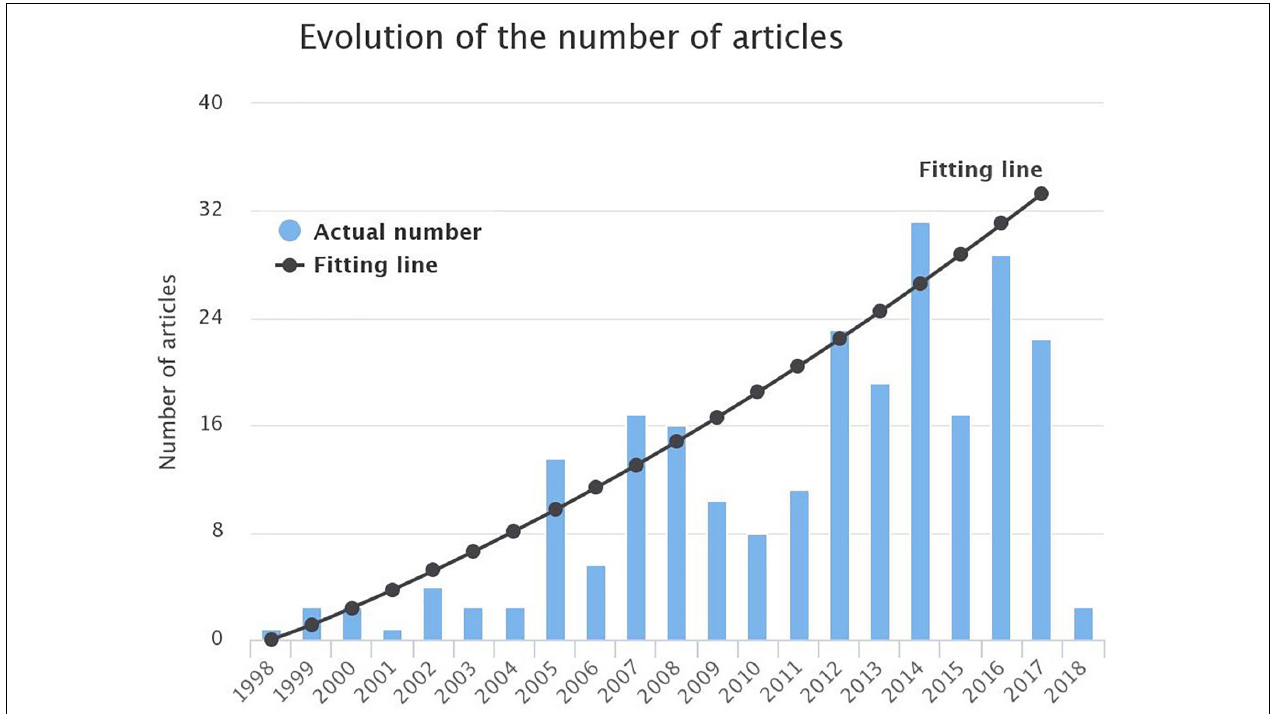
FIGURE 4 | Evolution of the number of publications in the field of AF modeling from 1998 till 1st March 2018. A parabolic line was found to fit better the data depicted in the bars ( R 2 = 0 . 7609).